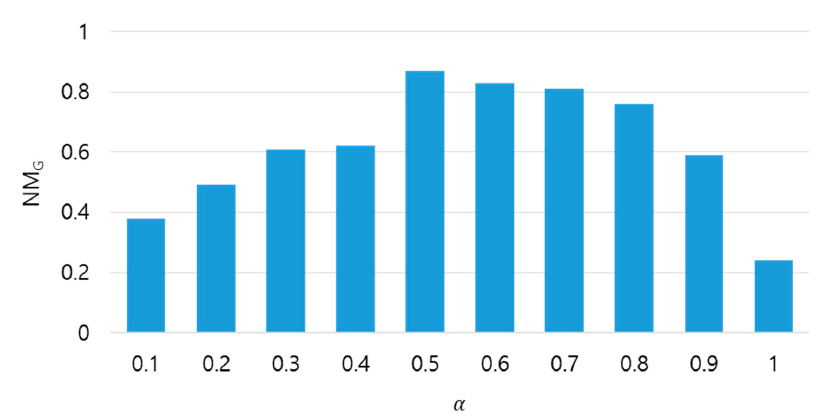
Figure 7. Comparison of NM G (network modularity) according to different thresholds.